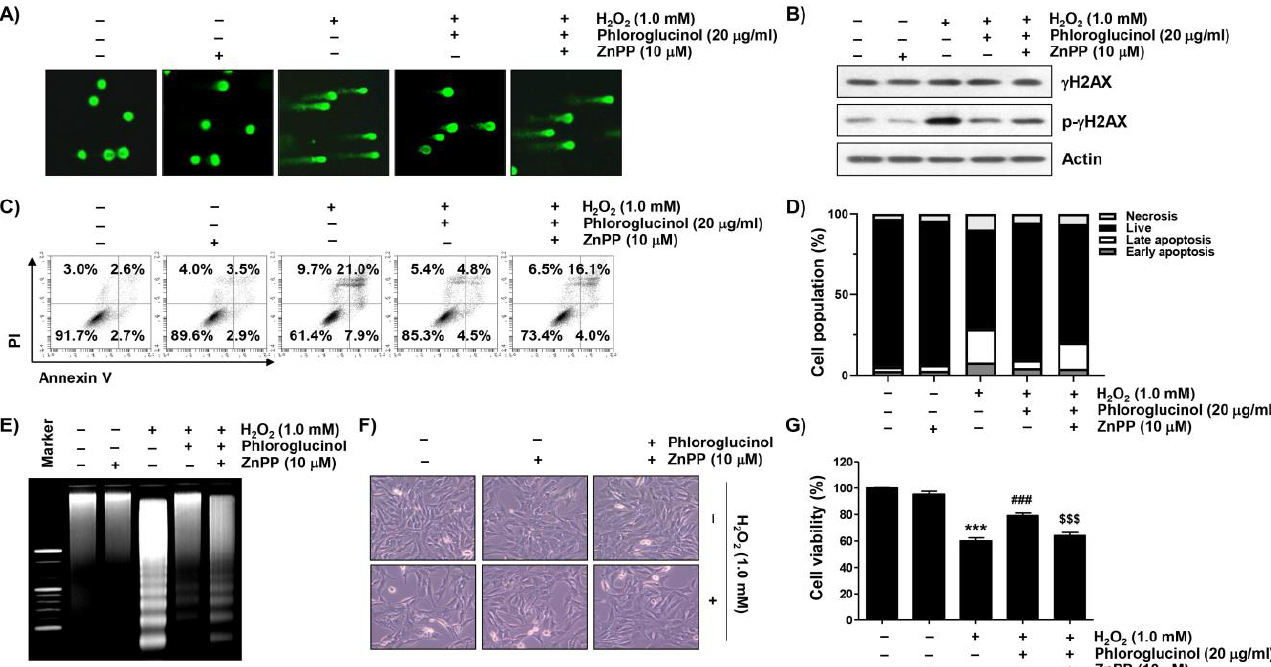
Figure 6. The inhibitory ability of phloroglucinol on DNA damage and apoptosis-induced by H 2 O 2 is offset by ZnPP in C2C12 myoblasts. Cells were treated with phloroglucinol and/or ZnPP for 1 h and then treated with H 2 O 2 for 24 h. Cells were exposed to vehicle for control group. ( A ) Representative images were captured after performing comet analysis (400 × ). ( B ) Changes in expression of γ H2AX and its phosphorylated form (p- γ H2AX) were determined by immunoblotting. ( C , D ) To measure the frequency of apoptosis, flow cytometry was performed after double staining with annexin V and PI. ( C ) Cells were classified as healthy cells (lower left quadrant, annexin V − /PI − ), early apoptotic cells (lower right quadrant, annexin V + /PI − ), late apoptotic cells (upper right quadrant, annexin V + /PI + ), and necrotic cells (upper left quadrant, annexin V − /PI + ). ( D ) Quantitative results following flow cytometry are presented. ( E ) Genomic DNA was visualized by EtBr staining after electrophoresis on an agarose gel. ( F ) Representative morphological images were indicated. ( G ) Cell viability was assessed by MTT assay. Statistical difference was determined by Student’s t -test (*** p < 0.001 vs. control group; ### p < 0.001 vs. H 2 O 2 -treated cells; $$$ p < 0.001 vs. phloroglucinol + H 2 O 2 treatment